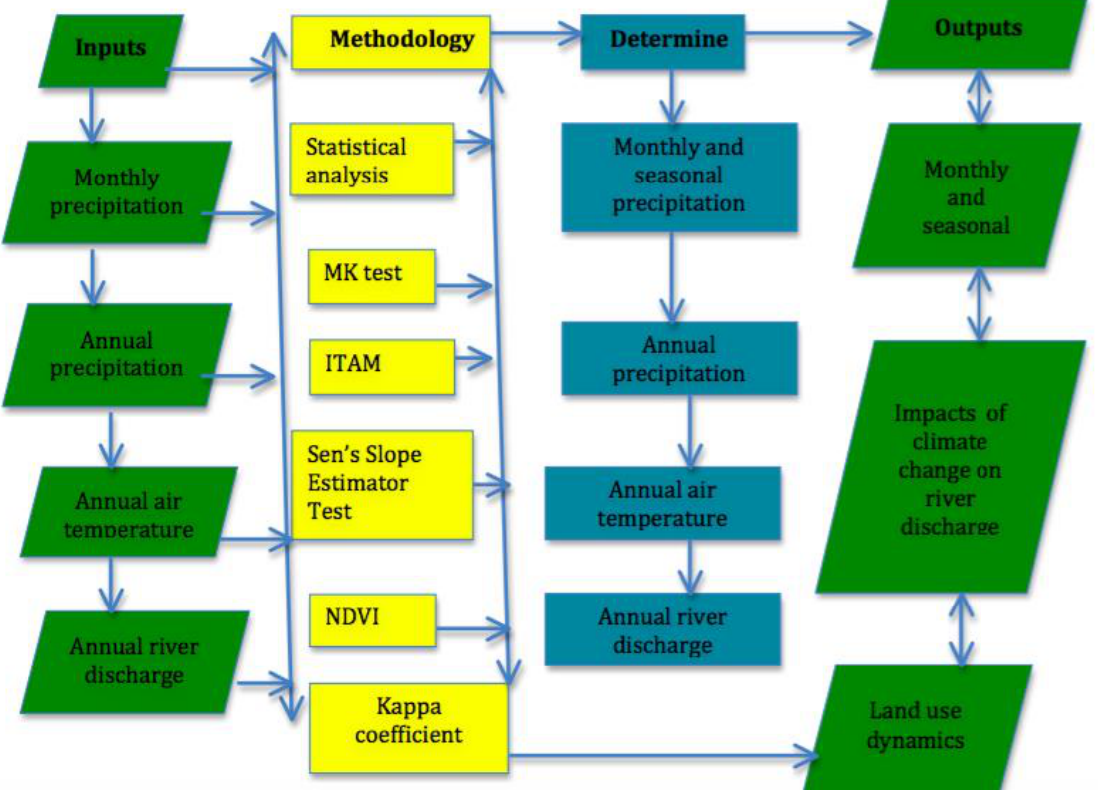
Figure 3. Spatially distribution land-use/land-cover map of the Huaihe River Basin.